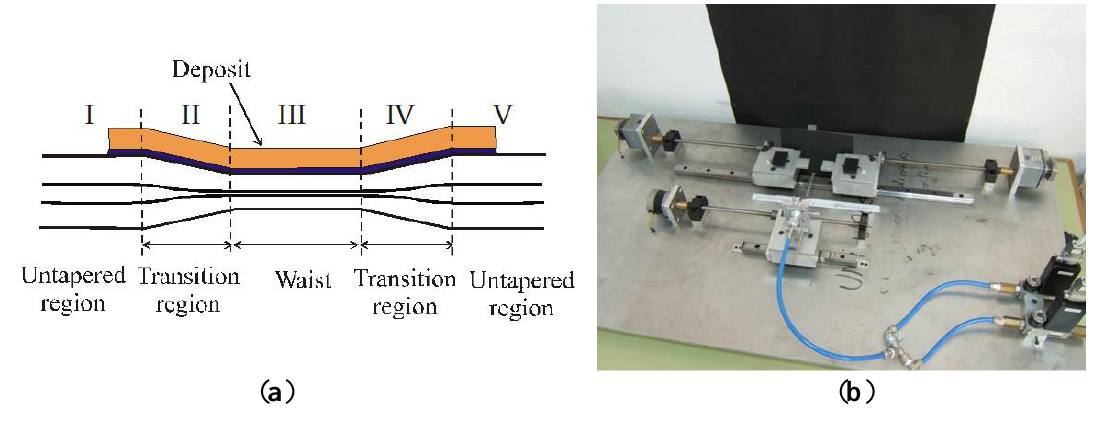
Figure 1. ( a ) A scheme of a uniform-waist taper, and its different regions; ( b ) A photograph of the fabrication